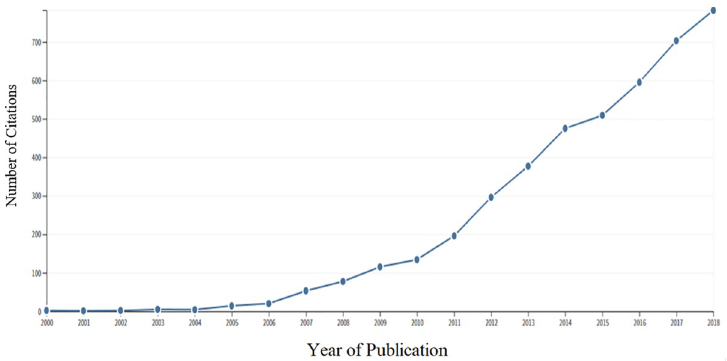
Fig 3. Year-wise number of citations accrued by publications on birth cohorts published from South Asia. Year- wise number of citations achieved by papers, pertaining to birth cohorts published in South Asia.